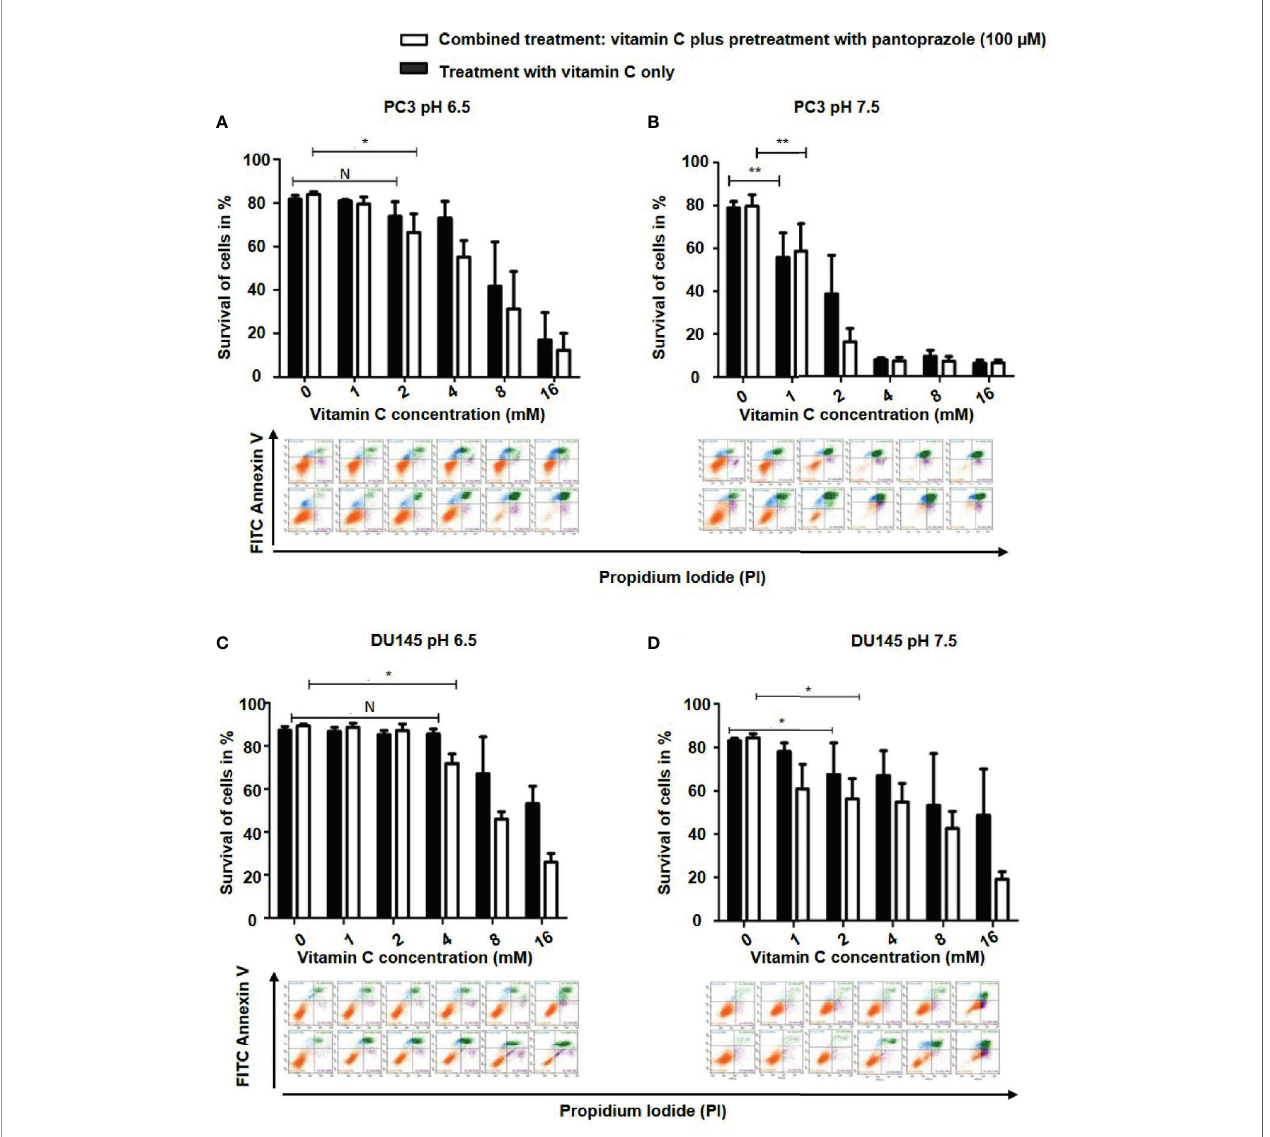
FIGURE 2 | Pantoprazole in combination with vitamin C induces apoptosis of prostate cancer cells. A total of 5x10 5 PC3 or DU145 cells per well (6-well plate) were incubated at 37°C in slightly acidic (pH 6.5) or slightly alkaline (pH 7.5) cell culture medium with different concentrations of vitamin C for 16 h following with or without pretreatment with pantoprazole (100 µM) for 24 h: Cells were incubated in cell culture medium with a pH of 6.5 ( A : PC3 cells; C : DU145 cells) or a pH of 7.5 ( B : PC3 cells; D : DU145 cells). Column diagram (upper panel): quanti fi cation of the FACS results. Colorized dot plot (bottom panel): FACS analysis data with increasing vitamin C concentrations as shown in the column diagrams (orange: surviving cells; green: PI- and AV- positive cells [apoptotic cells]; blue: PI-positive cells [necrotic cells]). Upper rows of the colorized dot plots: cells were treated with vitamin C only; bottom rows of the colorized dot plots: cells were treated with vitamin C and pantoprazole. The bars represent the mean and SD of the mean of n ≥ 3. N, not signi fi cant; *p < 0.05, **p <